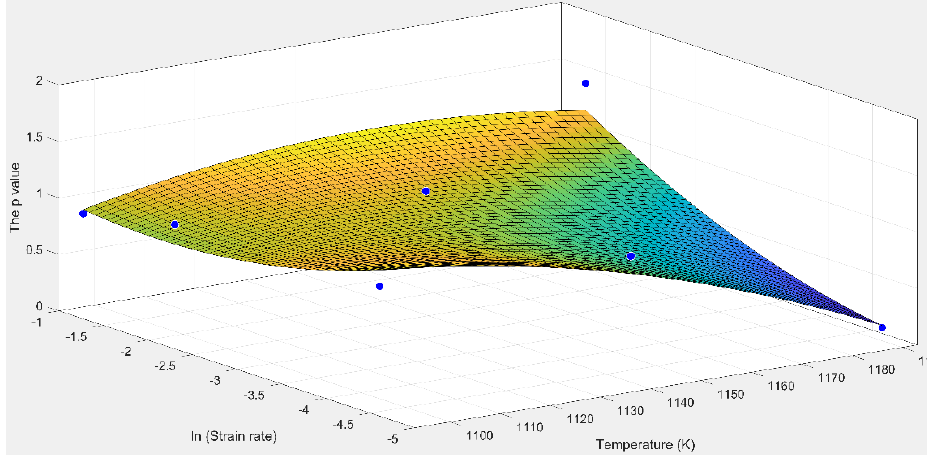
. ε . Figure 10. The relationship between parameter p and T and  .